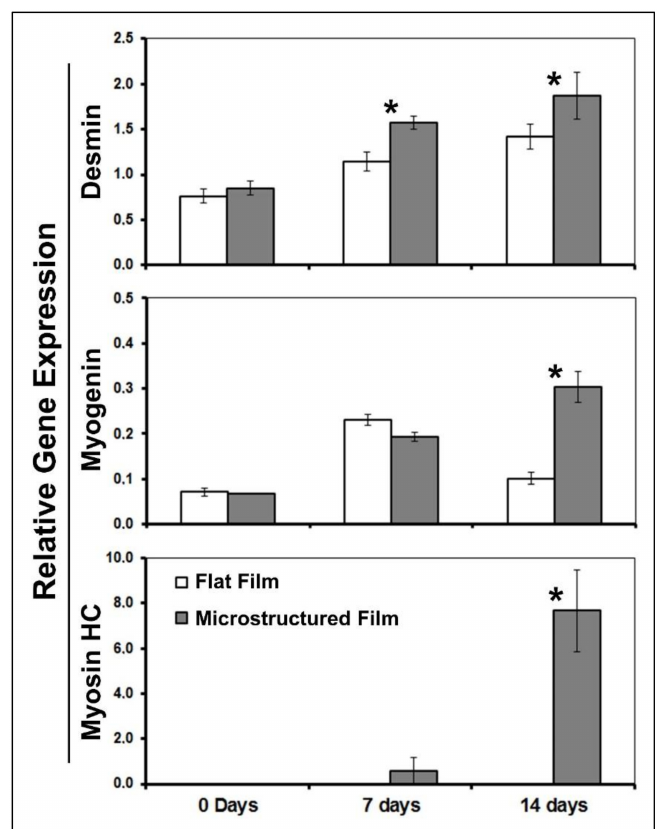
Figure 7. Gene expression of myogenic markers of cells cultured on flat and microstructured films. Asterisk (*) shows significant di ff erence ( p < 0.05; t -test; n = 3) between flat and microstrucured